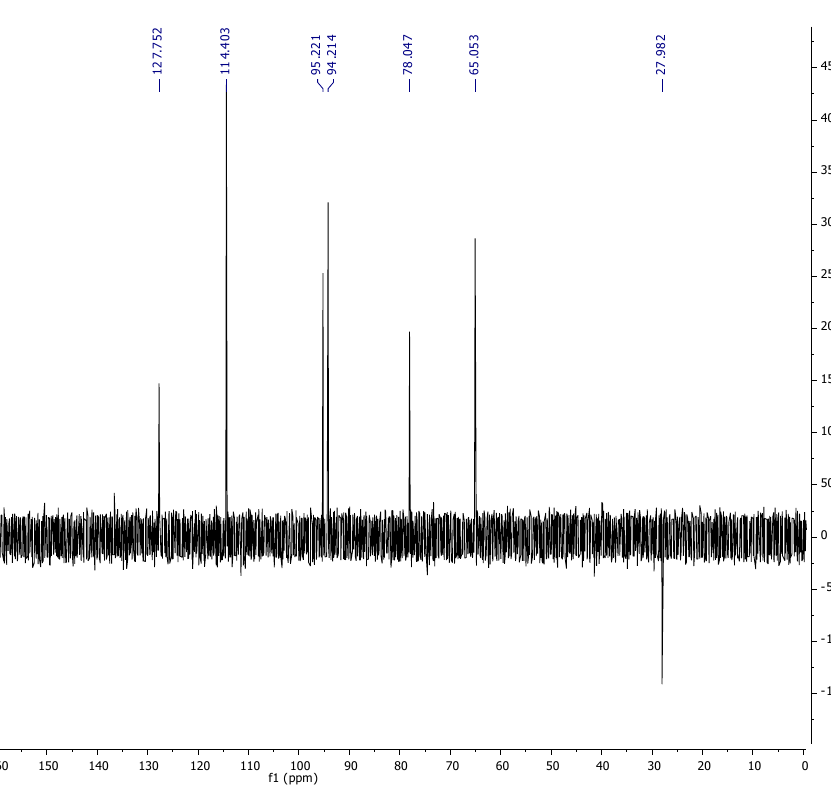
Figure 5. DEPT (Distortionless enhance by polarization transfer)-135 of the CFL-1 fraction of C. fistula leaves.